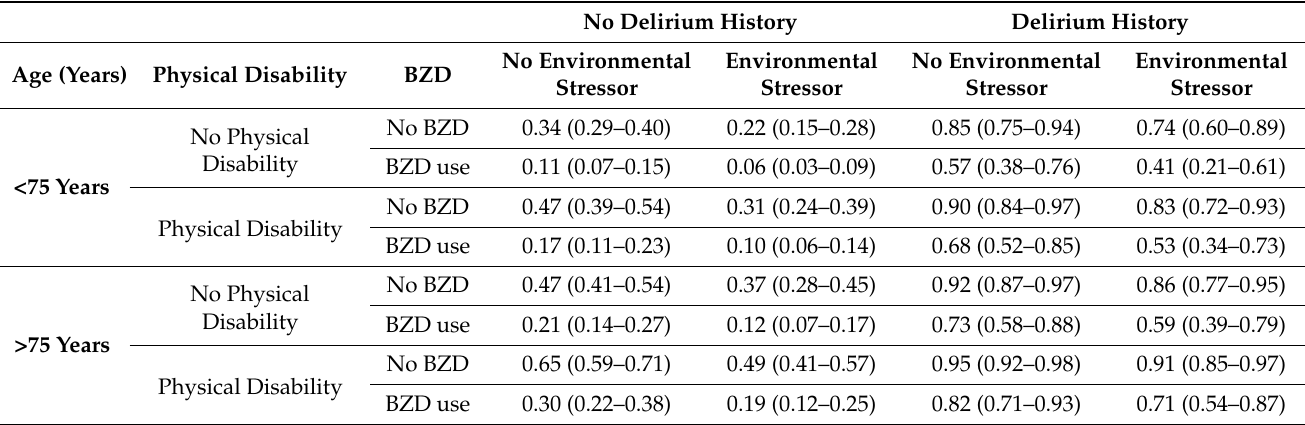
Table 4. Predictors of delirium according to the patient’s profile. No Delirium History